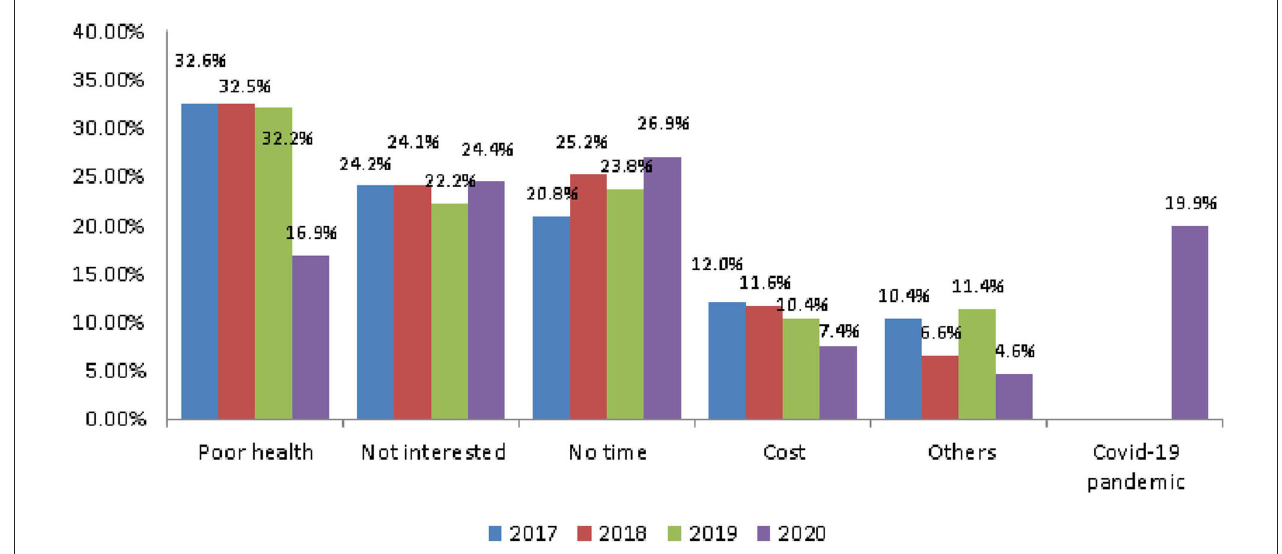
FIGURE 5 | The trend of reasons for not participating in tourism.